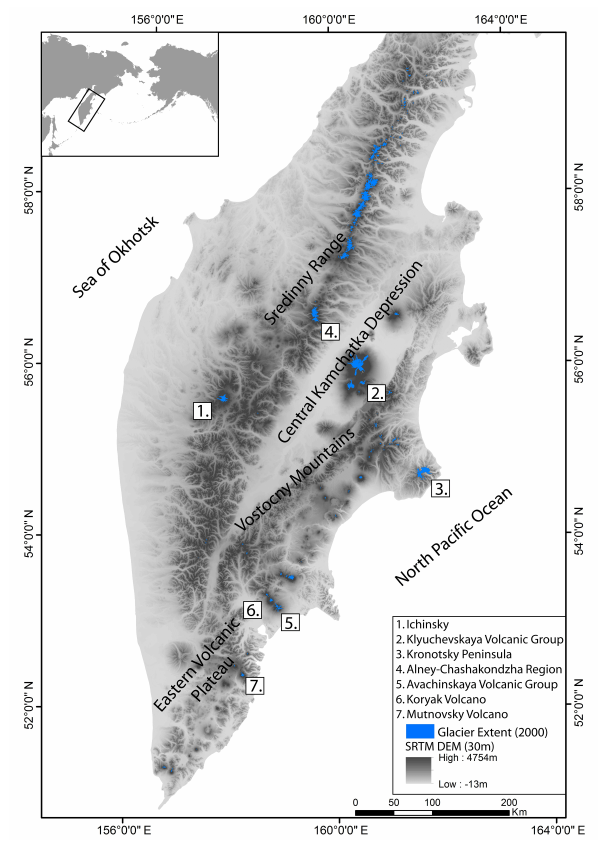
Figure 1. Map of the Kamchatka Peninsula (Russia) with glacier extent in 2000 shown in blue. Numbers refer to locations discussed in the